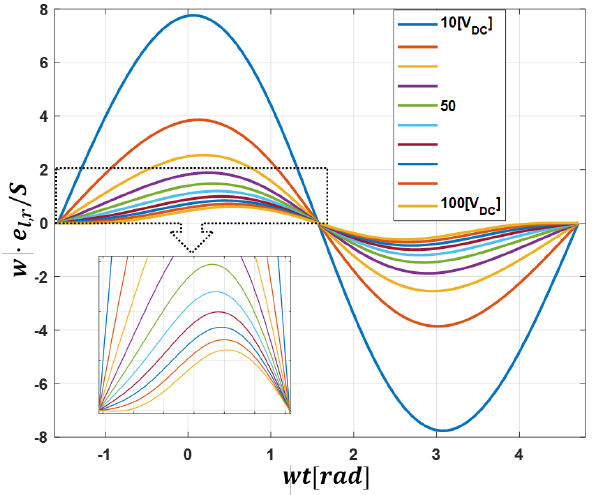
Figure 3. Converter energy per VA plot for varying levels of DC voltage ( steps of 10 V ) and a constant grid voltage of 220 V rms